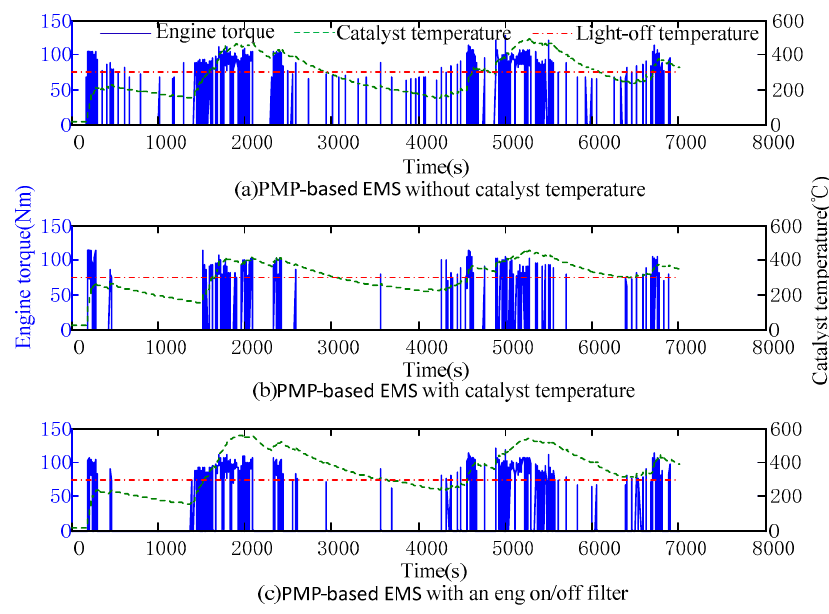
Figure 22. Simulation results under different EMSs for the UDDS–HWFET–UDDS driving cycle. Table 7. Vehicle’s fuel consumption and tailpipe emissions under different EMSs for the UDDS– HWFET–UDDS driving cycle.